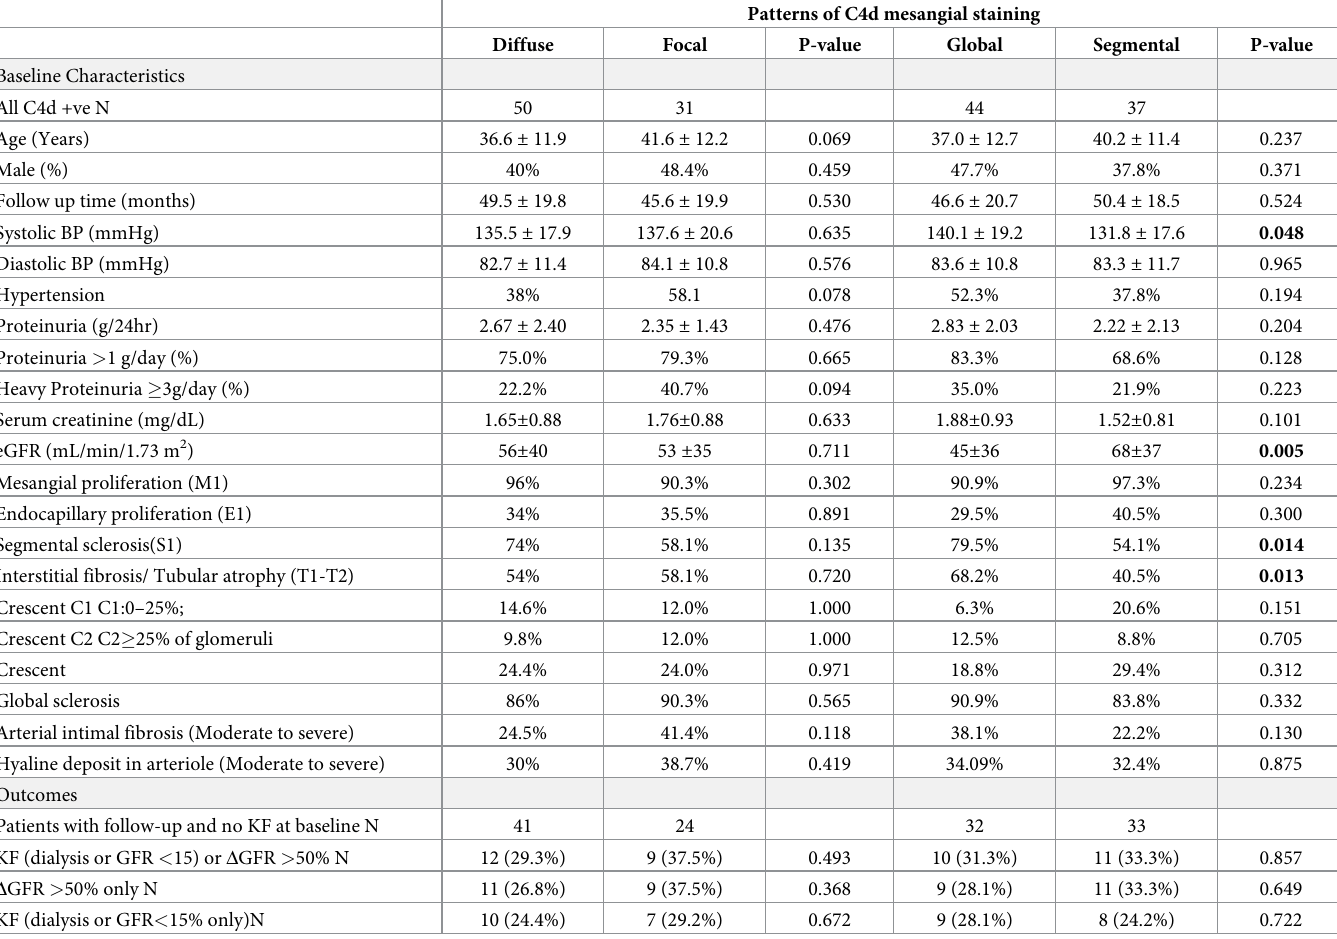
Table 2. Clinicopathological data at the time of kidney biopsy and outcomes at follow-up by patterns of glomerular mesangial C4d staining.